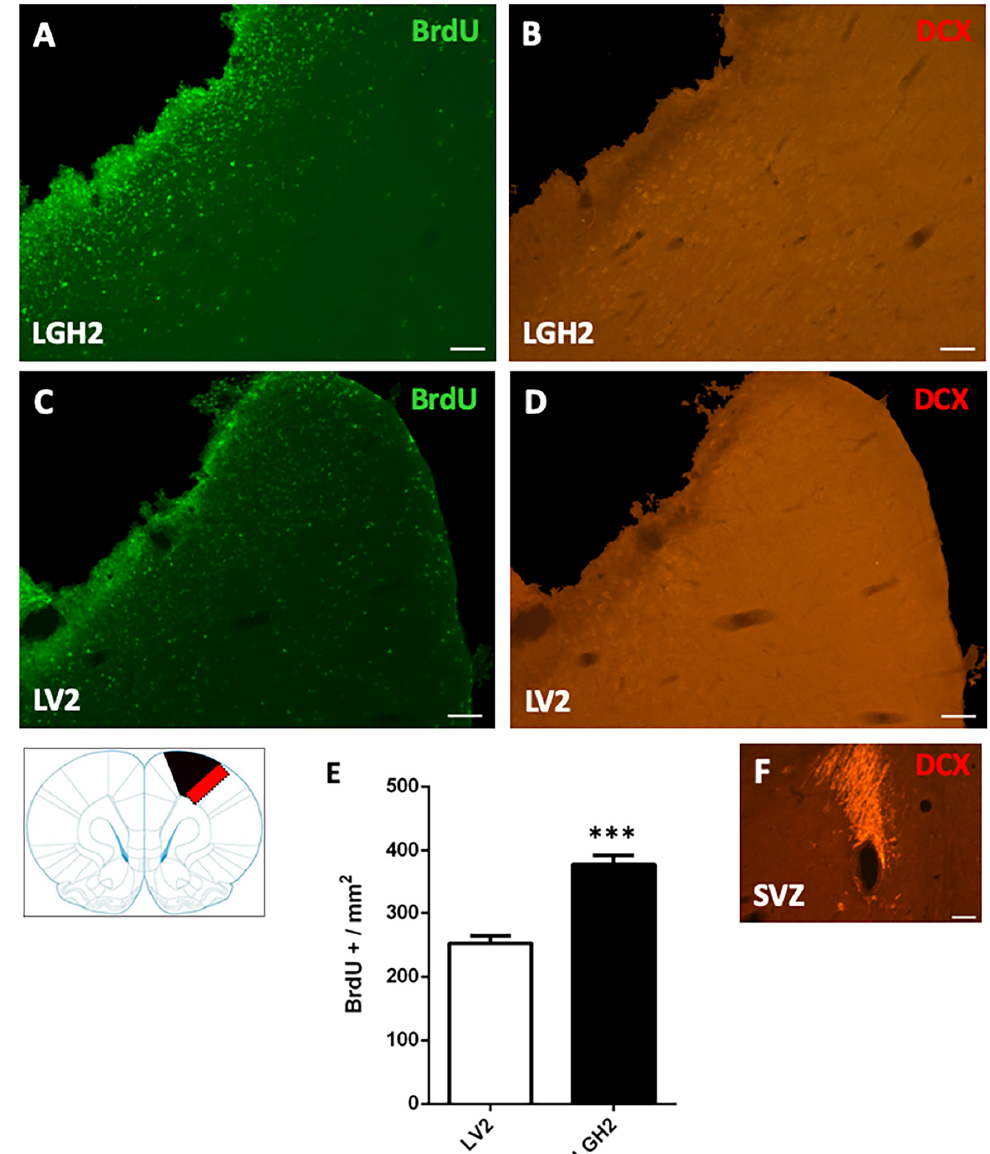
Figure 2. Cell proliferation in the perilesional motor cortex of animals sacrificed at 5 dpi. BrdU and doublecortin (DCX) labeling in the perilesional primary motor cortex, M1 (red rectangle in the scheme) of animals treated with GH ( A , B ) or vehicle ( C , D ), immediately after cortical ablation and sacrificed at 5 dpi. Coronal sections at +2.52 mm from Bregma. Scale bar = 200 µm. In ( E ) is shown the significant increase in BrdU-labeled cells (mean + SEM, n = 2) observed in GH-treated animals compared to vehicle-treated animals. ( F ) positive control of the DCX labeling in the subventricular zone (SVZ) of the lateral ventricle. In the scheme, the black image indicates the place where the ablation was produced. *** p < 0.0001 (Student’s t- test).